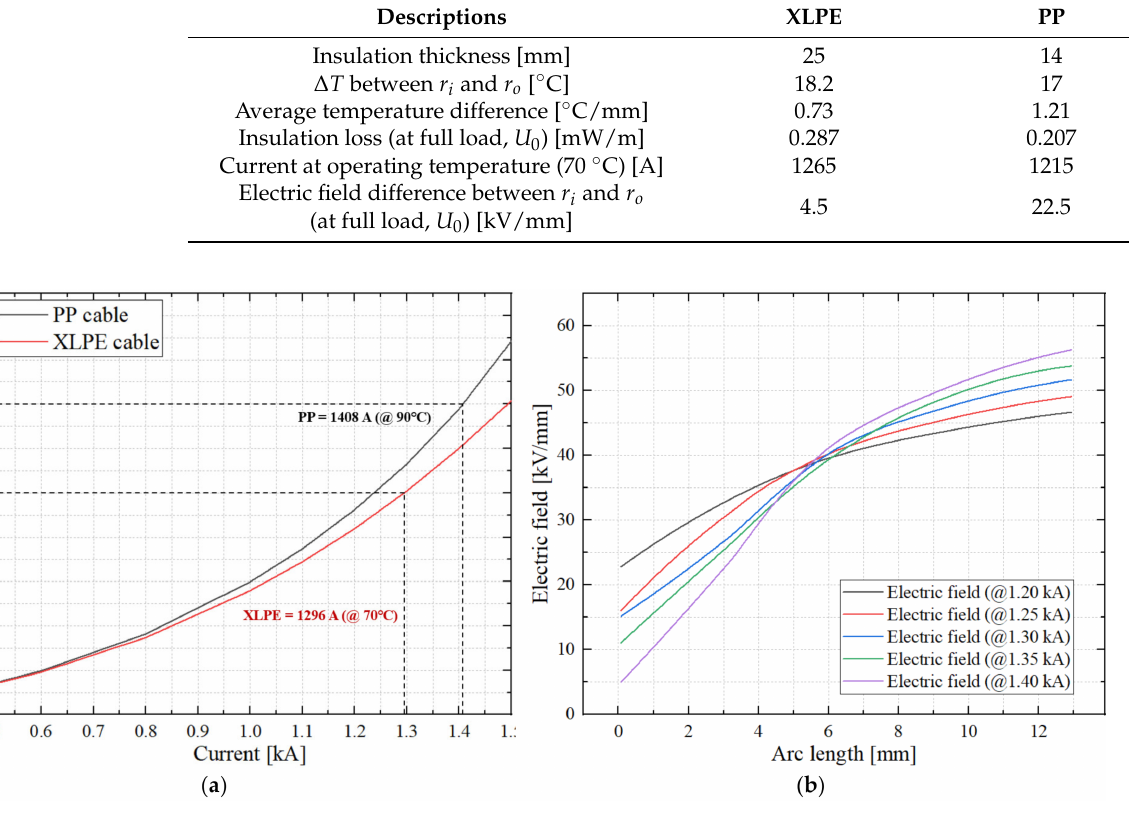
Figure 7. ( a ) Maximum temperatures of the XLPE and PP cable insulations with increasing currents; ( b ) electric field profiles of the PP cable by current variations (under U DC